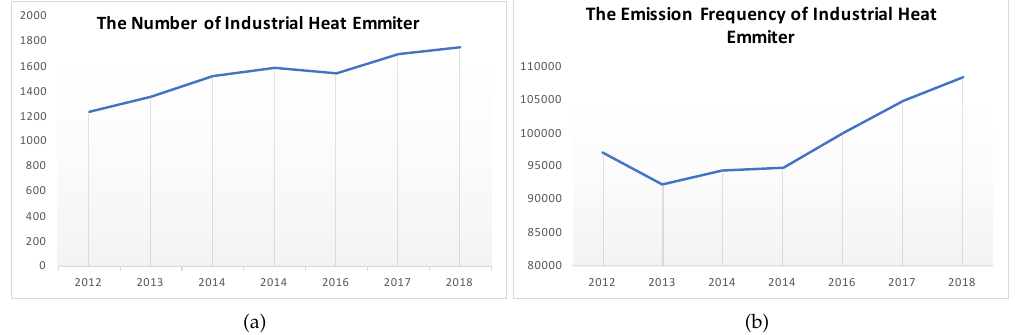
Figure 11. The temporal characteristics of detected working industrial heat releasers in the US from 2012 to 2018 (( a ) is for the amount of industrial heat releasers/sources, ( b ) is for the emmission frequncy of industrial heat releasers/sources).